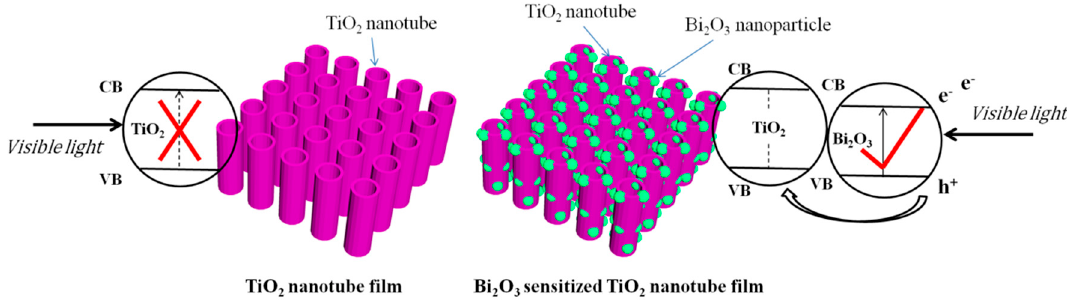
Figure 11. Photocatalysis mechanism of sensitizing TiO 2 by Bi 2 O 3 .